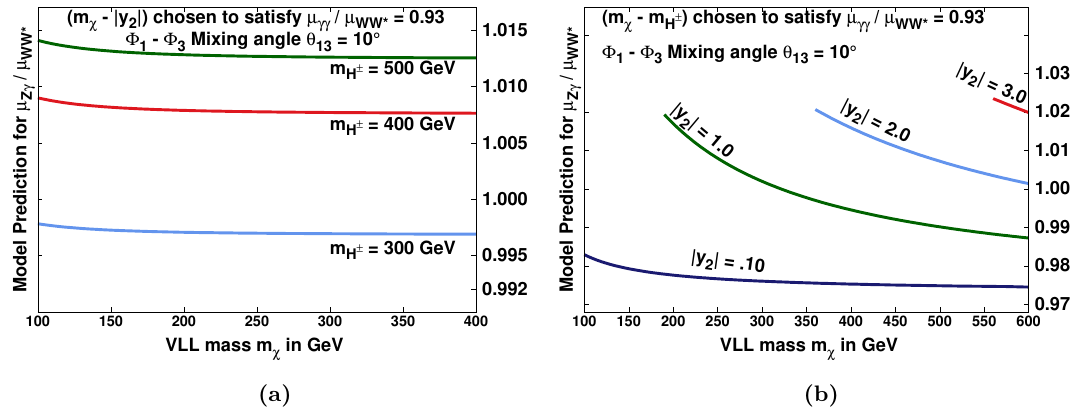
Figure 3. Variation of the ratio µ Zγ /µ WW ? with varying m χ for θ 13 = 10 ◦ . The values of ( m χ , | y 2 | ) in figure (a) and that of ( m χ , m ) in figure (b) are such that they satisfy the constraint H ± µ γγ /µ WW ? = 0 . 93 +0 . 17 [59] as depicted in figures 2a and 2b − 0 . 16